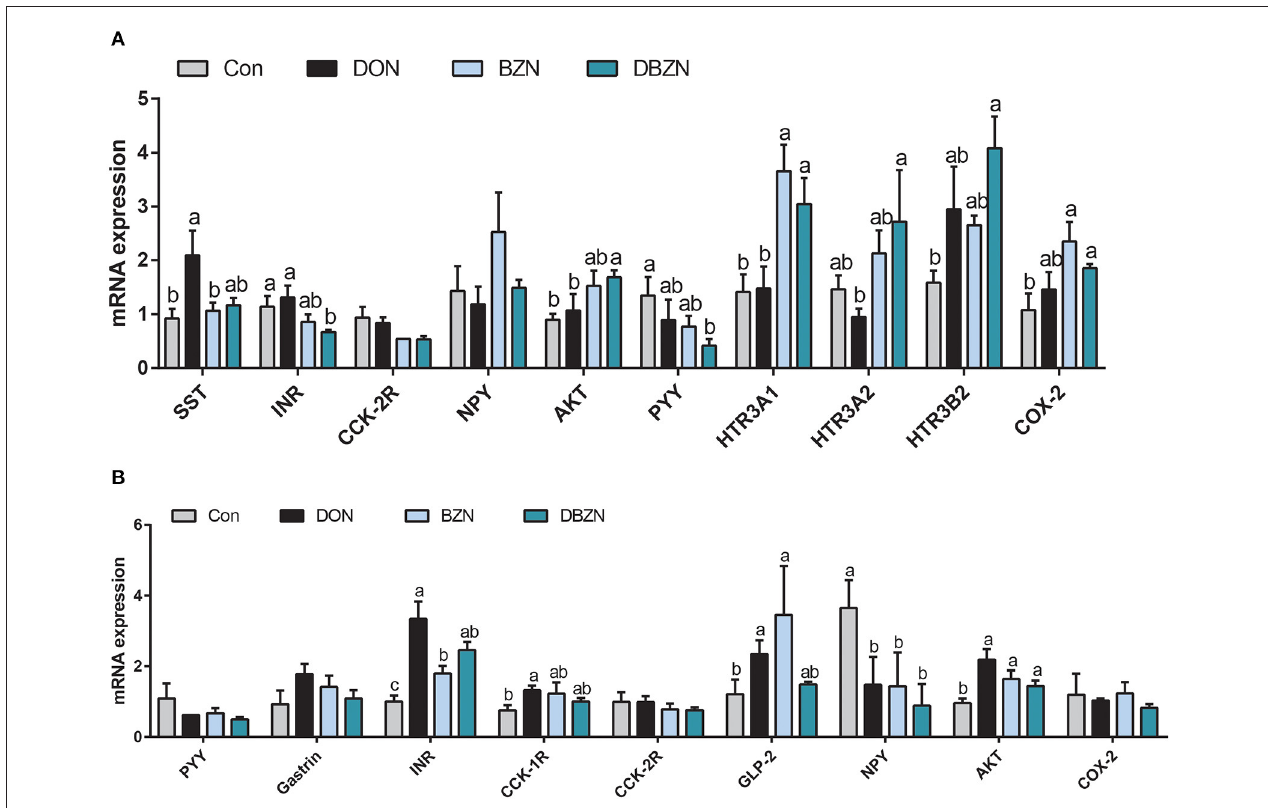
FIGURE 6 | Effect of DON and BZN in mRNA levels of hormone genes in hypothalamus (A) and pituitary gland (B) . Column was mean ± SEM ( n = 7). Different letters mean significant differences. Dietary treatment: Con, basal diet; DON, 4 mg/kg DON-contaminated diet; BZN, 0.5% BZN supplementation diet; DBZN, 0.5% BZN supplement in 4 mg/kg DON-contaminated diet. SST, somatostatin; INR, insulin receptor; CCK-2R, cholecystokinin B receptor; NPY, neuropeptide Y; AKT, AKT serine/threonine kinase 1; HTR3A1, 5-hydroxytryptamine receptor 3A 1; HTR3A2, 5-hydroxytryptamine receptor 3A 2; HTR3B2, 5-hydroxytryptamine receptor 3B; COX-2, cyclooxygenase-2; CCK-1R, cholecystokinin type A receptor; GLP-2, glucagon-like peptide 2; BZN, baicalin–zinc complex; Con, control; DON, deoxynivalenol. a,b different letters means significantly difference ( P <